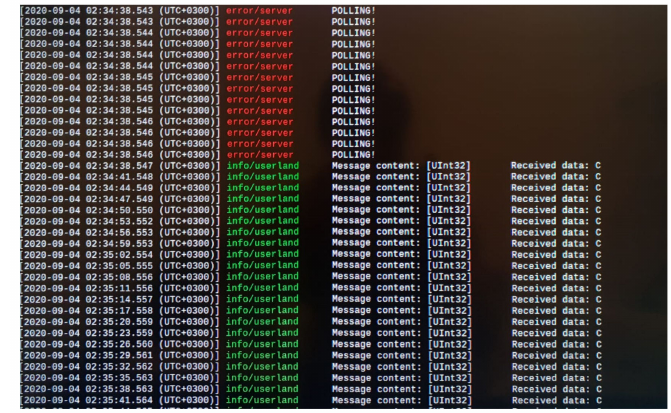
Figure 7. Terminal of the Broker App receiving data from the Publisher and transmitting it to the subscribers.